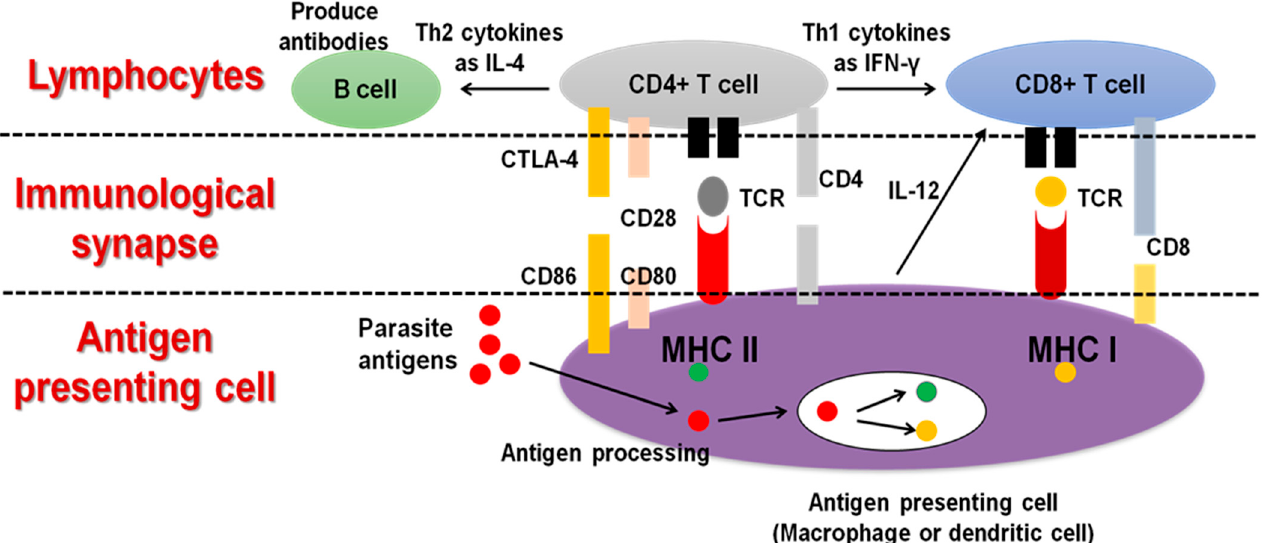
Figure 3. Immunological synapse between antigen presenting cells and lymphocytes. In case of infection and antigen release, antigen presenting cells (APCs), mostly DCs or macrophages, will act for antigen processing and presentation for triggering the subsequent proper immune response. The molecular interactions occurring at the interface between APC and T cells is determined by the type of pathogen and stage of infection and will determine the subsequent infection. The molecular interactions include T-cell receptor (TCR) and cluster of differentiation CD-28, CD-80, CD-86 and CD-8 for binding to the MHC class I or II on the APC surface and can determine the activation of T-helper (CD4+) and T-cytotoxic cells (CD8+), respectively.